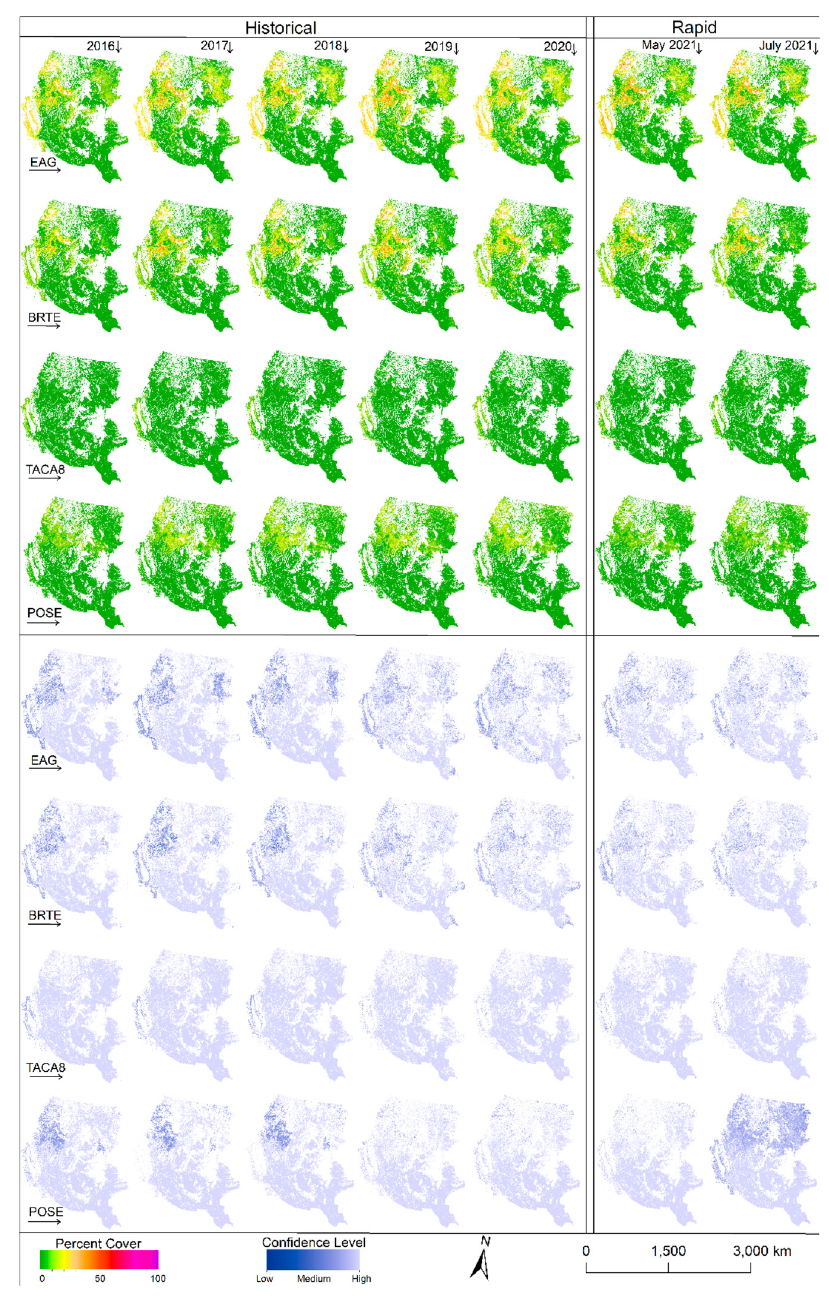
Figure A2. Annual abundance and associated confidence maps for exotic annual grasses (EAG), cheatgrass (BRTE), medusahead (TACA8), and Sandberg bluegrass (POSE) for all mapped time